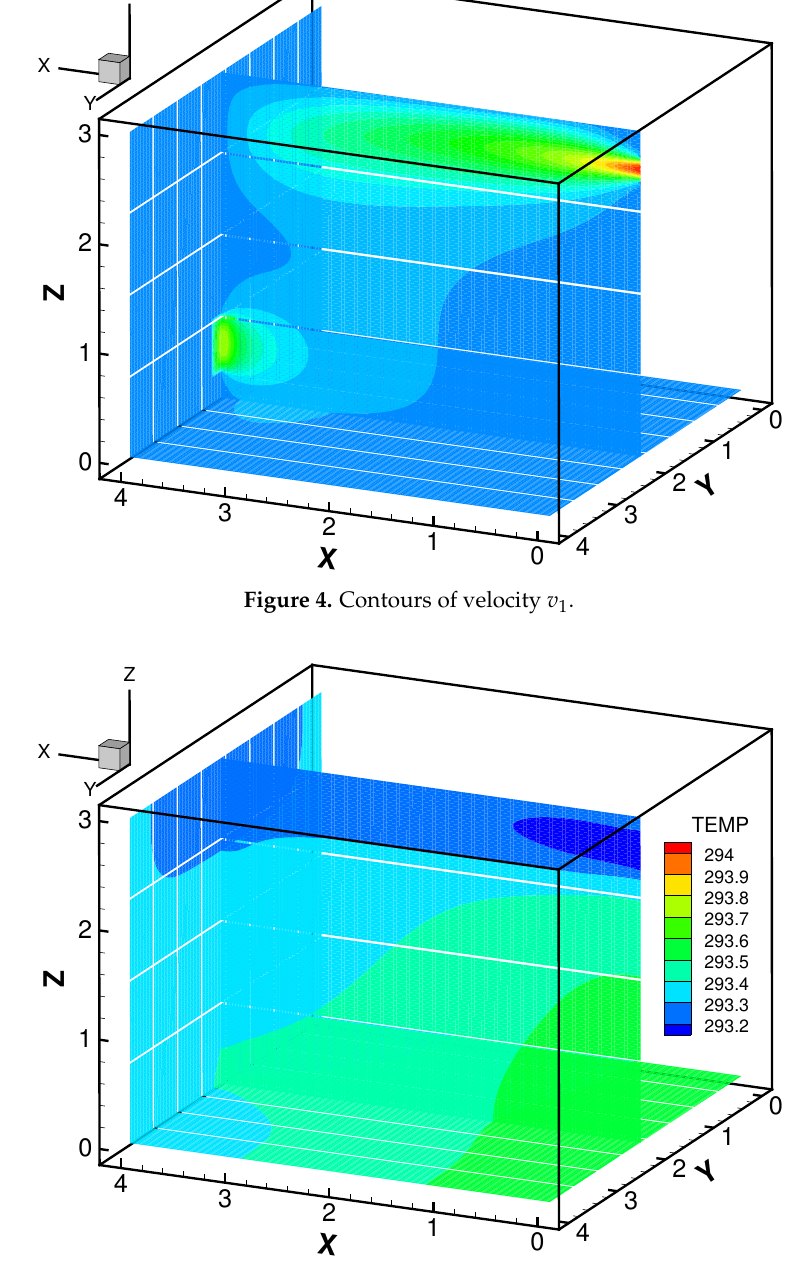
Figure 5. Contours of temperature T in Kelvin